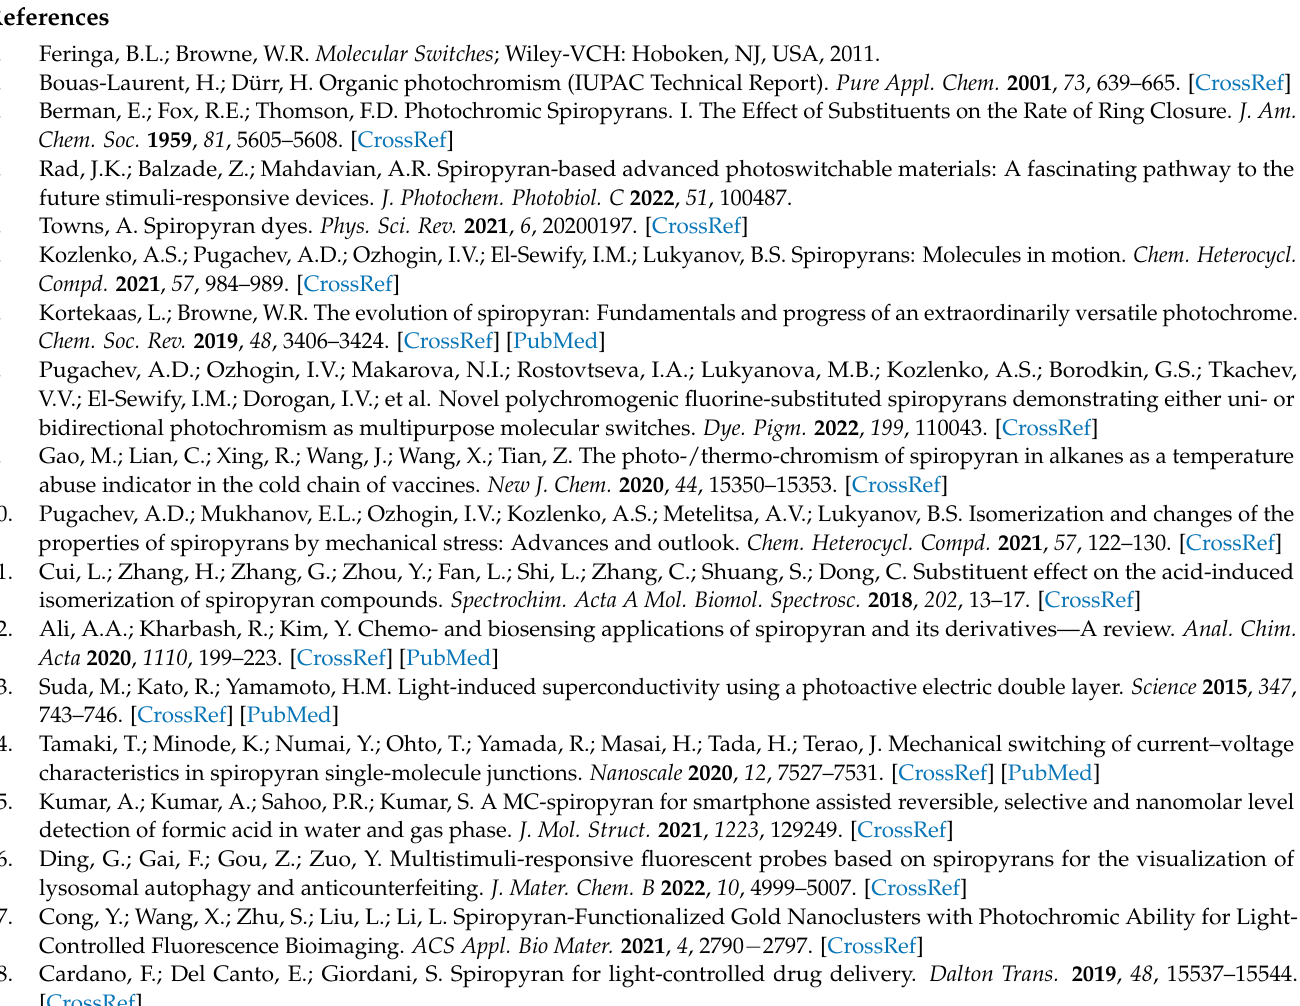
Figure S8: mass-spectrum of compound 1 . Figure S9: The UV/Vis, fluorescence emission, and fluorescence excitation spectra of compound 1 . Figure S10: Kinetic curve of the thermal recyclization reaction of compound 1